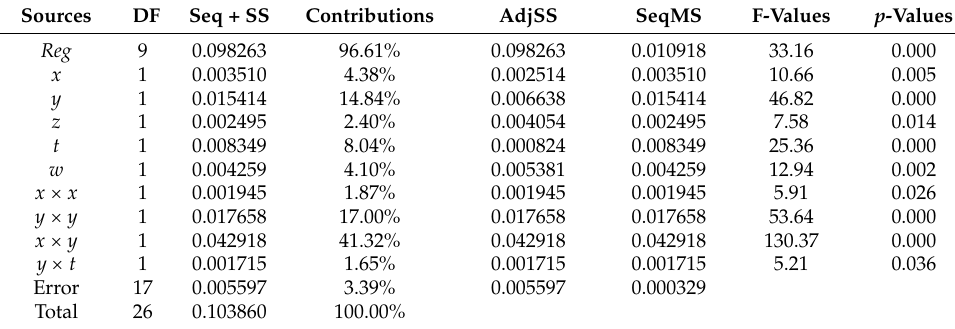
Table 7. Details of ANOVA results (GRG).